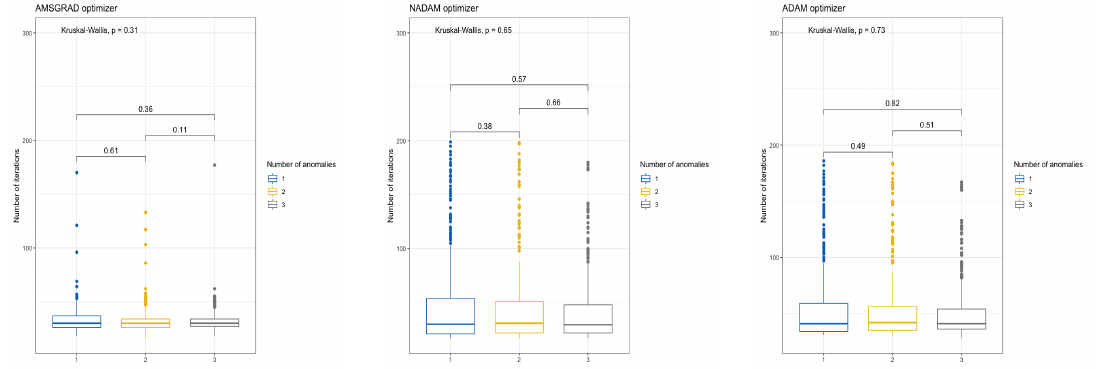
Figure 5. Kruskal–Wallis test on number of anomalies for different optimizers with the resulting p -value of the test for each